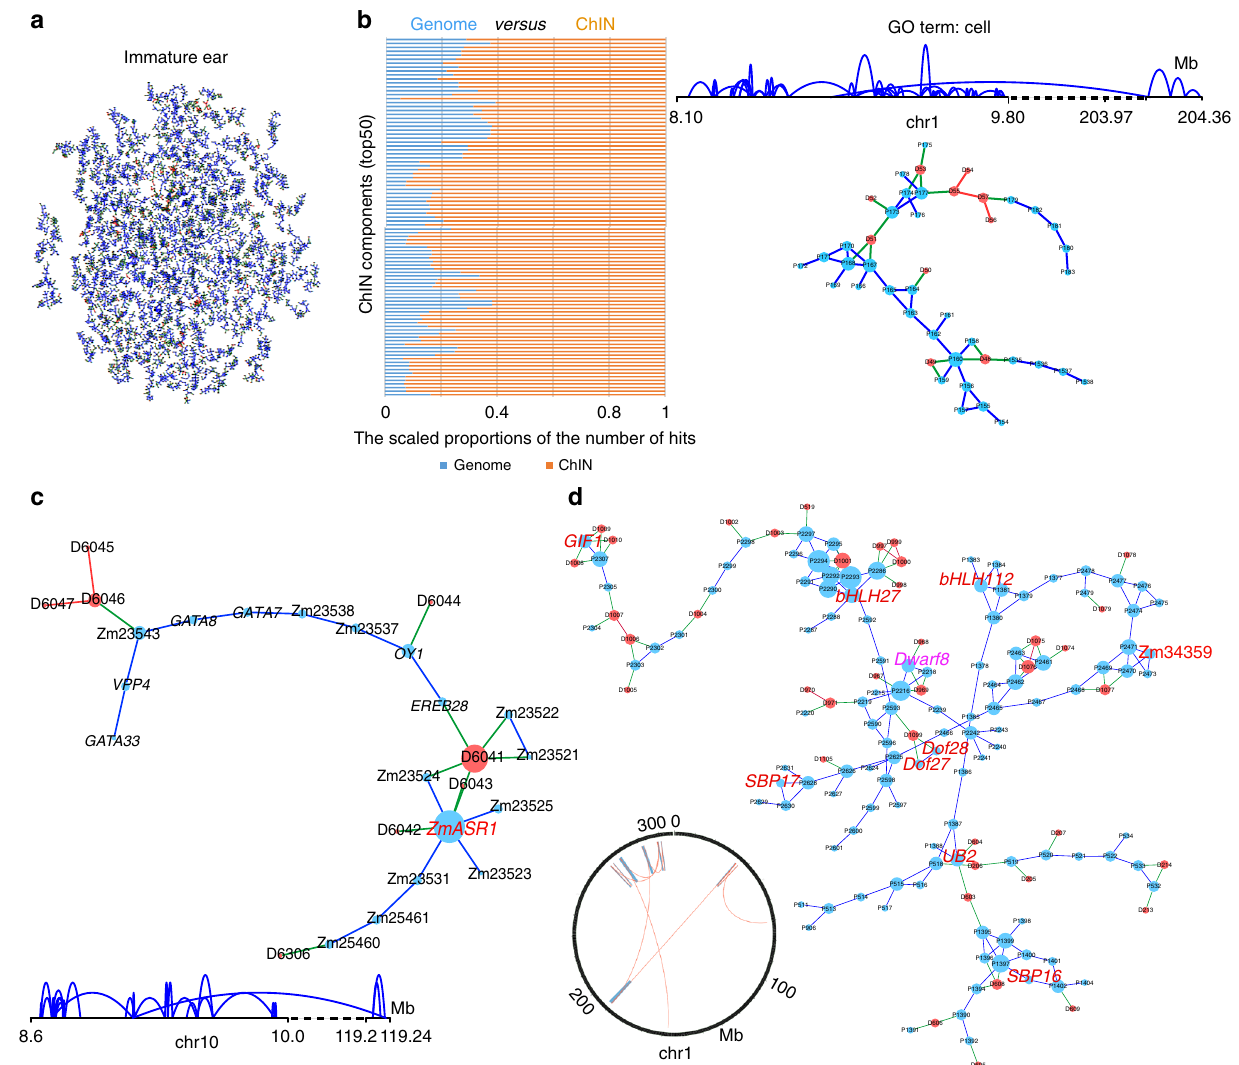
Fig. 7 Functional communities of chromatin interactions in chromatin interaction network (ChINs). a All the ChINs identi fi ed in immature ear. Here only showed the ChINs with more than 30 nodes. b Enrichment of gene ontology (GO) terms in top 50 ChINs in immature ear and shoot. Only signi fi cant GO terms (false discovery rate (FDR) <0.05) are presented in the left panel. Enrichment of GO terms is represented as scaled proportions of the observed number of hits in a ChIN component (orange) vs. the expected number of hits in the genome (blue). The right panel showed a ChIN in immature ear, where all genes were enriched in cell function (GO term). c The ChIN for ZmASR1 (in red) in shoot. The arc map in left bottom showed the region span of all chromatin interactions in this ChIN on genome. d The ChIN for Dwarf8 (in pink), which regulates plant height and fl owering time, in immature ear. There were other nine genes ( GIF1 , UB2 , bHLH27 , bHLH212 , DOF27 , DOF28 , SBP16 , SBP17 , and Zm34359; in red) potentially associated with fl owering in this ChIN. Circos map in the left bottom showed the region span of all chromatin interactions in this ChIN. Chromatin interactions with distance longer than 1 Mb are highlighted by orange arcs, others in blue. Ellipses in blue and red indicated proximal PET peaks (P) and distal PET peaks (D), respectively, in ChIA-PET datasets. P – P, P – D, and D – D interaction are presented in blue, green, and red edges in network. Source Data of Fig. 7d are provided as a Source Data fi